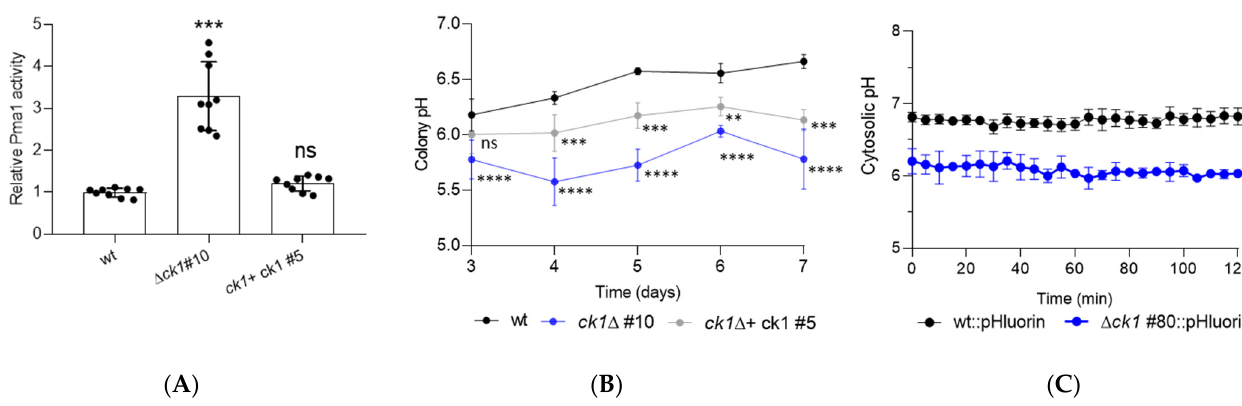
Figure 4. Ck1 negatively regulates Pma1 activity and controls pH homeostasis. ( A ) Pma1 ATPase activity was assayed in total membrane fractions isolated from germlings of the indicated strains after 15 h incubation (see Section 2). The activity was normalized to that of the wt strain. p < 0.001 (***), ns, not significant versus wt according to Welch’s test. Data shown are the mean and standard deviation from three independent experiments with three technical replicates each. ( B ) Aliquots of 5 × 10 4 fresh microconidia of the indicated strains were spot ‐ inoculated on minimal medium agar (MMA) plates and incubated for 7 days. At the indicated time points, 4 mm 2 squares were cut from the center of each colony, homogenized in 50 μ L of ultrapure water, and the pH was measured with a microelectrode. p < 0.0001(****), p < 0.001 (***), and p < 0.01 (**) versus wt according to two ‐ way ANOVA and Turkey Test. Data presented are the mean and standard deviation from three independent biological experiments, each with three colonies analyzed. ( C ) Cytosolic pH (pH c ) was monitored in germlings of the indicated strains expressing the ratiometric pH probe pHluorin Microconidia were germinated 15 h in YD medium buffered at pH 7.4, germlings were washed and resuspended in KSU buffer at pH 6.0, aliquoted into microwells and pre ‐ incubated 60 min at 28 °C, before monitoring pH c spectrophluorometrically every 5 min for 2 h. For pH c measurements, the ratio between the emission intensities (collected at 510 nm) after excitation at 395 nm and 475 nm was calculated. Data show the mean and standard deviation of three independent replicate wells from one representative experiment. Experiments were performed three times with similar results.